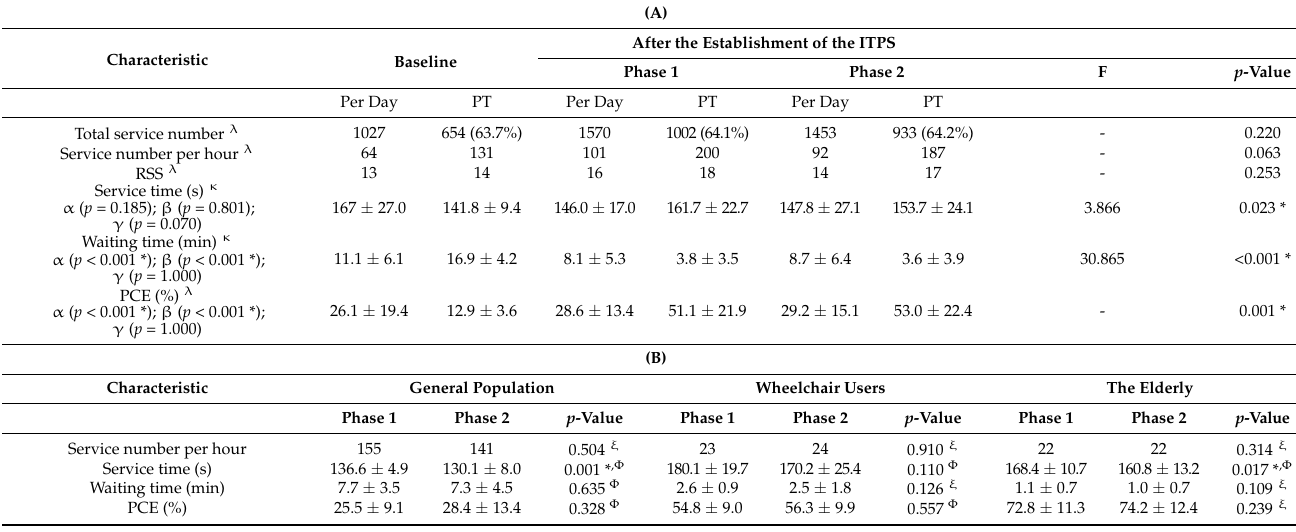
Table 1. The characteristic of the study: ( A ) Service details of phlebotomy among the baseline period (July 2014), phase 1 (1 November 2018 to 31 May 2019), and phase 2 (1 June and 30 October 2019); ( B ) The comparison of the subgroup between phase 1 and phase 2 in peak time.